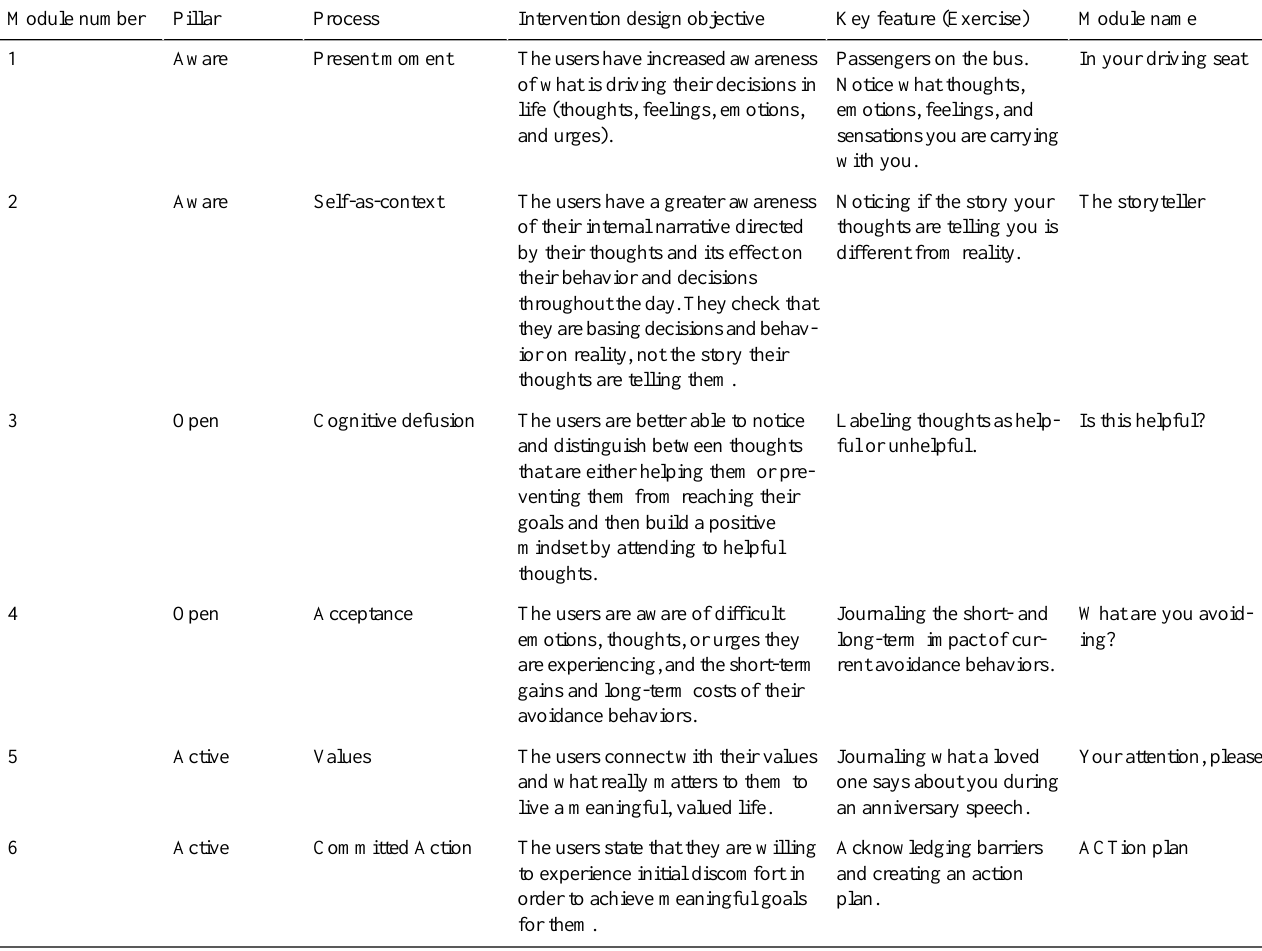
Table 1. The structure of the digital intervention prototype. The outline evidences the 3 core pillars of ACT a alongside the 6 ACT processes and links the intervention design objectives with the intervention key features (module name and